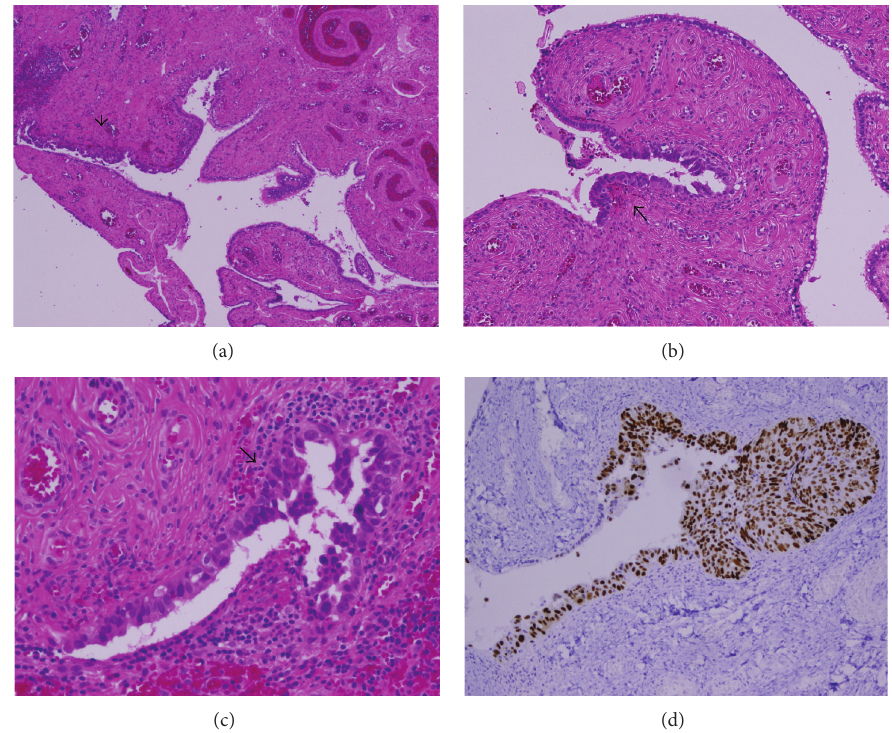
Figure 1: (a) H&E stain of the distal fimbriated end of the left fallopian tube. At low magnification, the area of STIC demonstrates increased epithelial thickness and nuclear stratification compared to areas of normal tubal epithelium. (b) Area of STIC with nuclear stratification and moderate variability in size and shape. Also note the absence of ciliated cells within the lesional area. (c) At high magnification, nuclear atypia is clearly visible, including hyperchromatism, prominent nucleoli, loss of polarity, and increased mitotic figures. (d) Strong and diffuse nuclear TP53 staining of